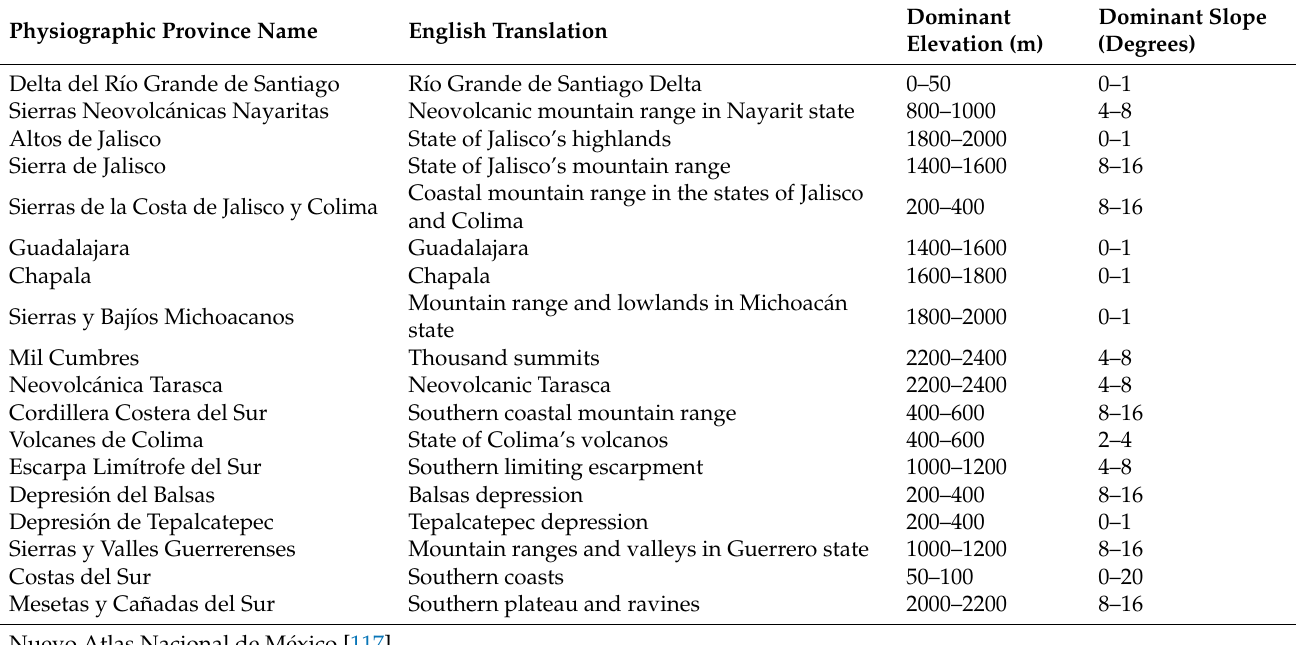
Table A1. Physiographic provinces’ general characteristics.